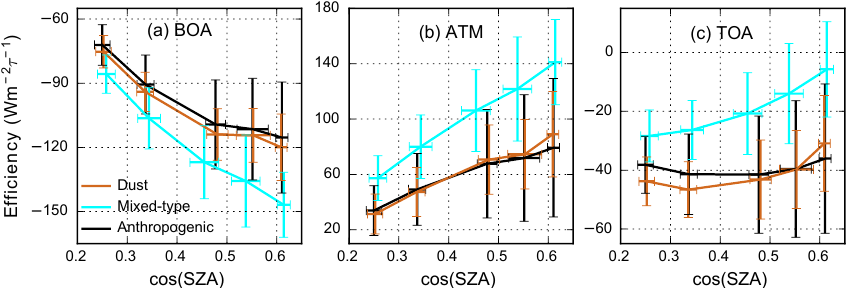
Figure 7. Direct aerosol radiative efficiency as a function of the cosine of solar zenith angle for the dust, mixed-type and anthropogenic aerosols: (a) BOA, (b) ATM, and (c) TOA.